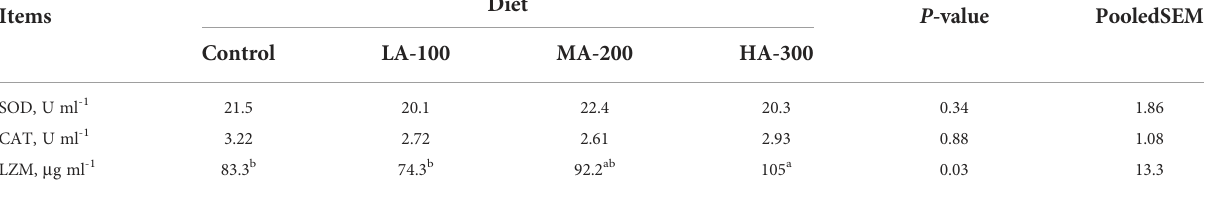
TABLE 3 Serum biochemical parameters of largemouth bass fed diets with different levels of b -glucan. Items